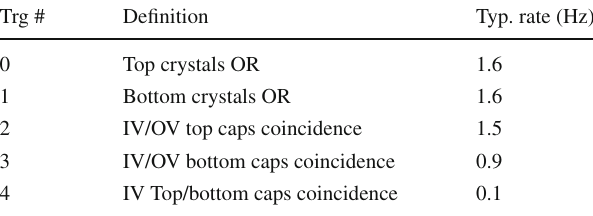
Table 1 Summary of trigger bits implemented for the BDX-MINI